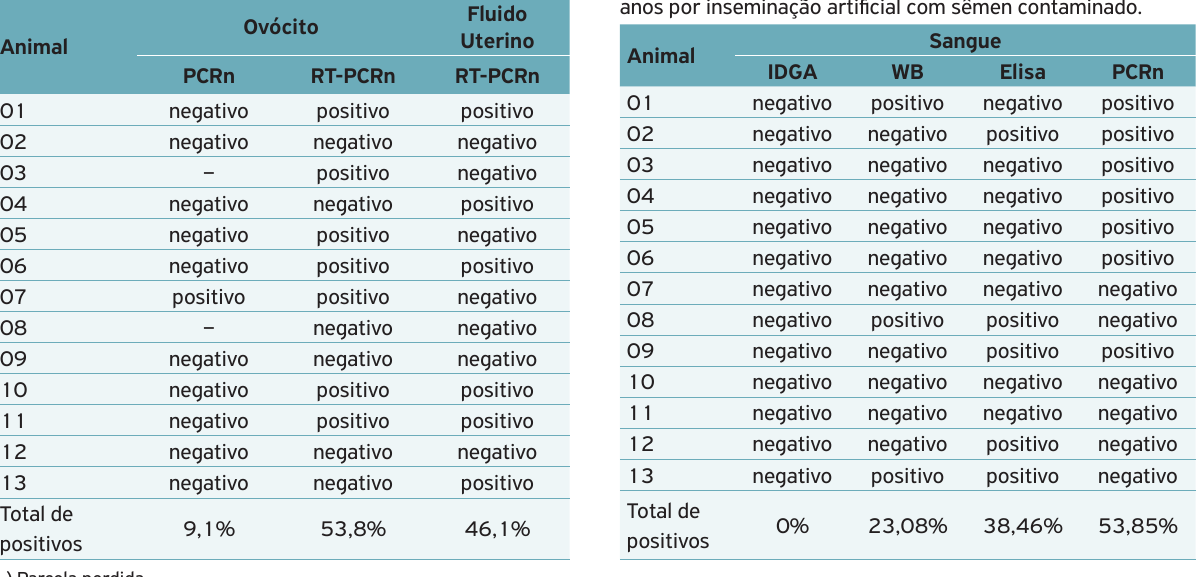
Tabela 1. Resultados de PCRn e RT-PCRn para identificação de DNA pró-viral e do RNA do vírus da Artrite Encefalite Caprina em amostras de ovócitos e fluido uterino de cabras infectadas por inseminação artificial com sêmen